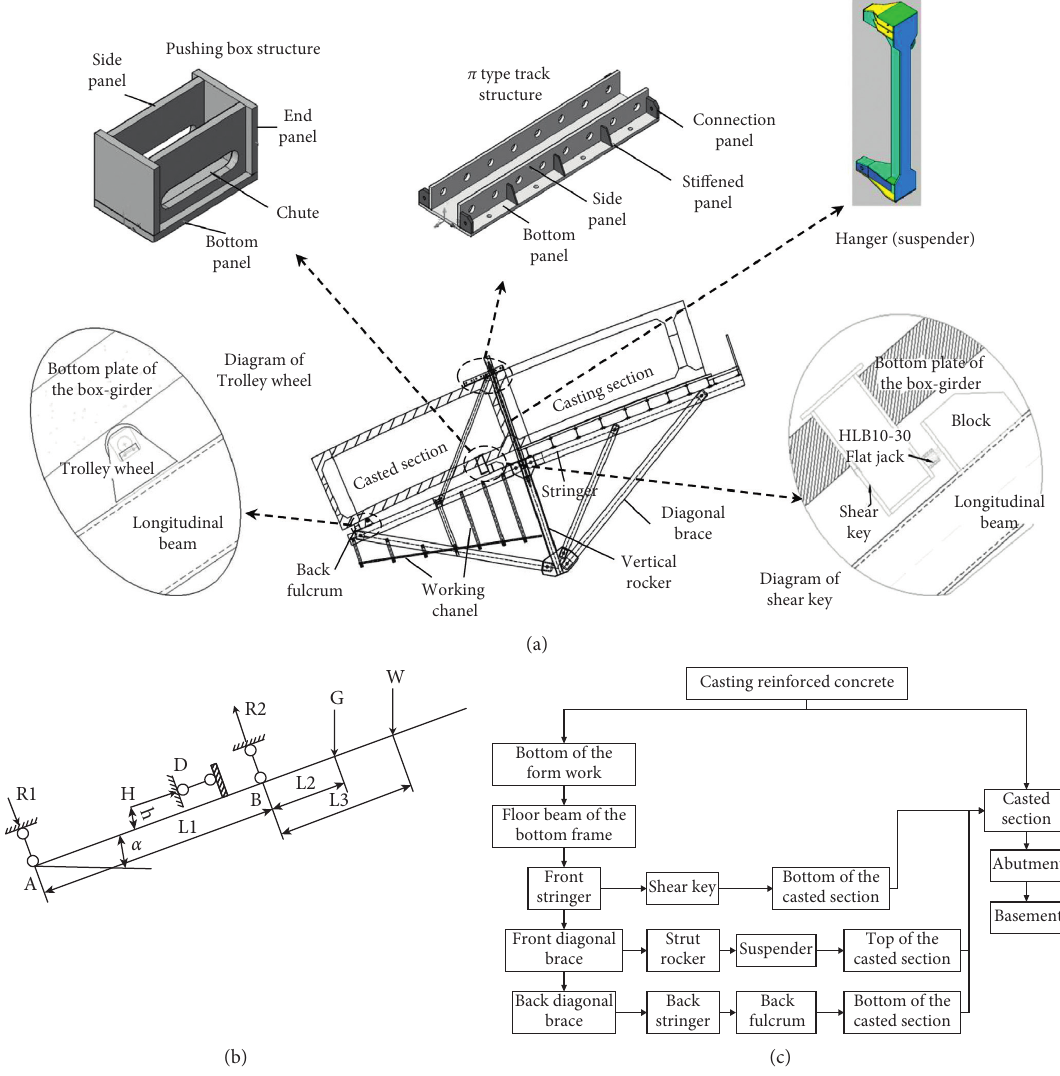
Figure 4: Technical details and force transmission rules of the inverted triangle form traveler. (a) Technical details of the form traveler. (b) Diagram of the force principle. (c) Force transferring of the